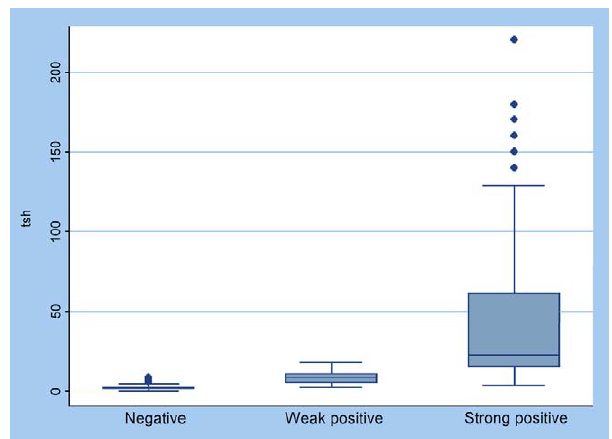
Figure 1. Negative, weak positive, and strong positive test results versus quantitative TSH level (TSH units: m